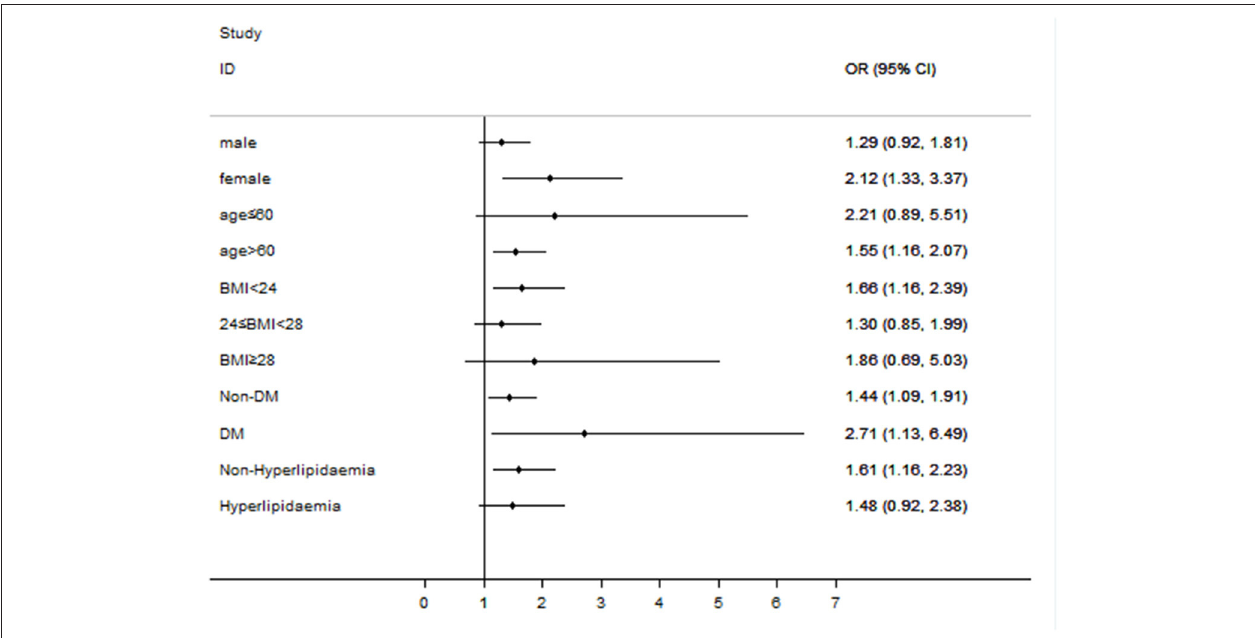
FIGURE 2 | Subgroup analyses: the relationship between ANGPTL8 levels and renal dysfunction varied among subgroups divided according to sex, age, BMI, and underlying disease status. Subgroup analyses of the OR of RD according to a 1-SD increase in ANGPTL8 levels. The final model was adjusted for age, sex, BMI, diabetes, and hyperlipidaemia, except for the stratifying